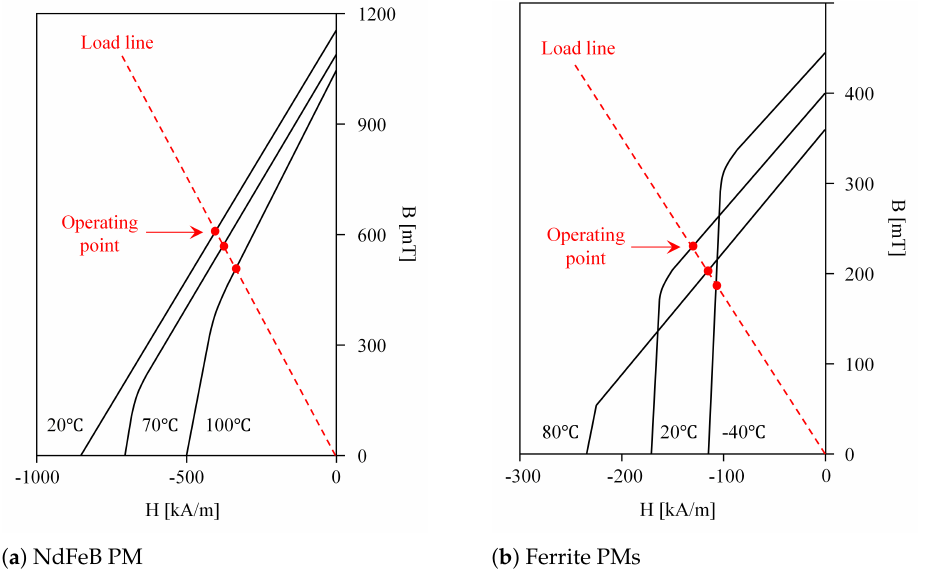
Figure 13. B-H characteristic of NdFeB PM and Ferrite PMs.